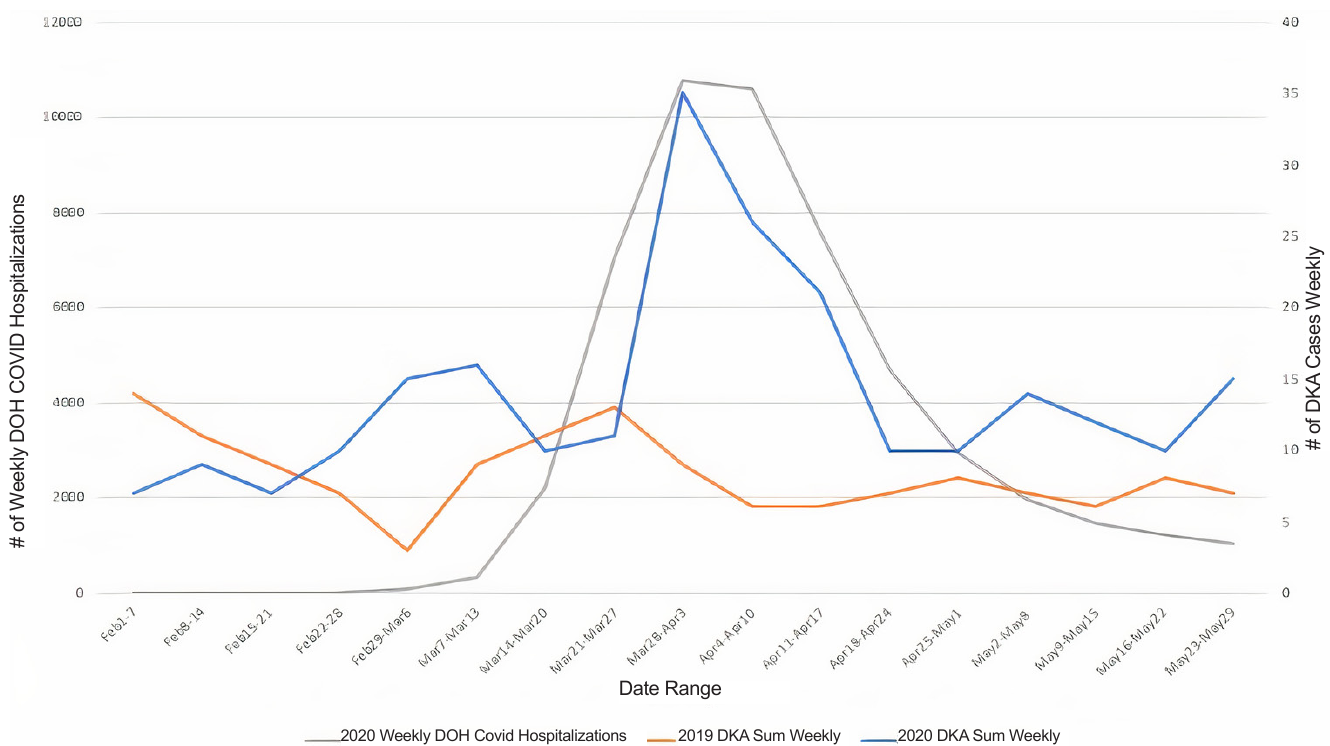
Figure 1. New York City weekly COVID-19 hospitalizations vs visits for diabetic ketoacidosis, 2019 vs 2020. DOH, Department of health; DKA, diabetic